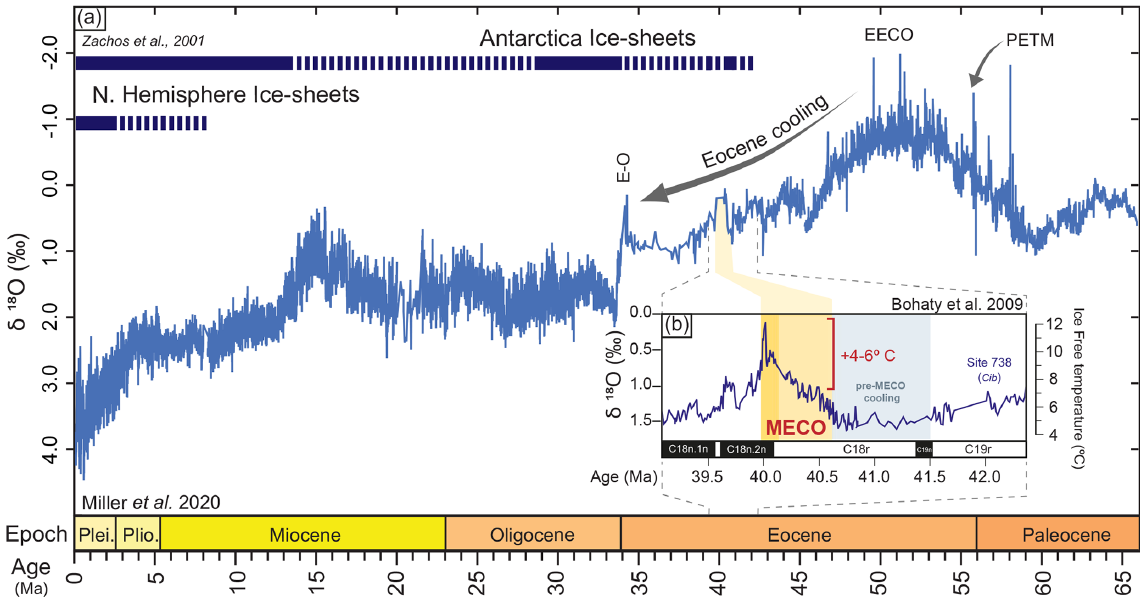
Figure 1. (a) Cenozoic δ 18 O values compilation from the Pacific Ocean, compiled in Miller et al. (2020). The continuous blue bar represents permanent ice sheet presence, and the discontinuous blue bar represents ephemeral ice sheet, modified from Zachos et al. (2001). Main climate events: EECO – Early Eocene Climatic Optimum; PETM – Palaeocene–Eocene Thermal Maximum; MECO – Middle Eocene Climatic Optimum; E–O – Eocene–Oligocene transition. (b) Carbonate δ 18 O values of site 702 from Bohaty et al. (2009). General climatic context of the Middle Eocene Climatic Optimum. The MECO “event”, in yellow from ca. 40.5 to 40.0Ma in the inset, is considered the last hyperthermal of the Eocene, immediately preceding the shift to genuine Antarctic glaciation and the ice-house world of the